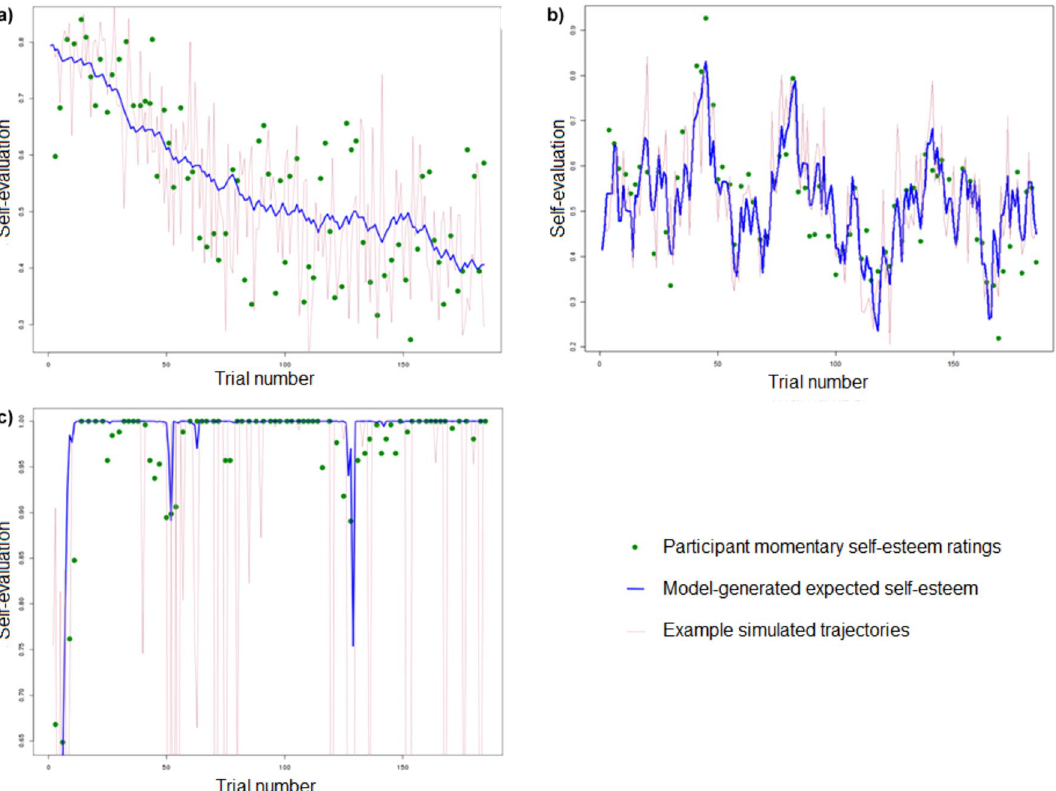
Figure 4. Self-esteem plots for three participants. Correlations between model-produced expected self-esteem values and actual self-esteem ratings were high for all 3, at 0.744, 0.858 and 0.818 respectively. ( a ) Example of gradual change in self-evaluation, in the context of noisy responding ( b ) SE following rather precisely the changes in recent approval and disapproval ( c ) ‘Brittle’ high SE. These patterns are seen in participants across both